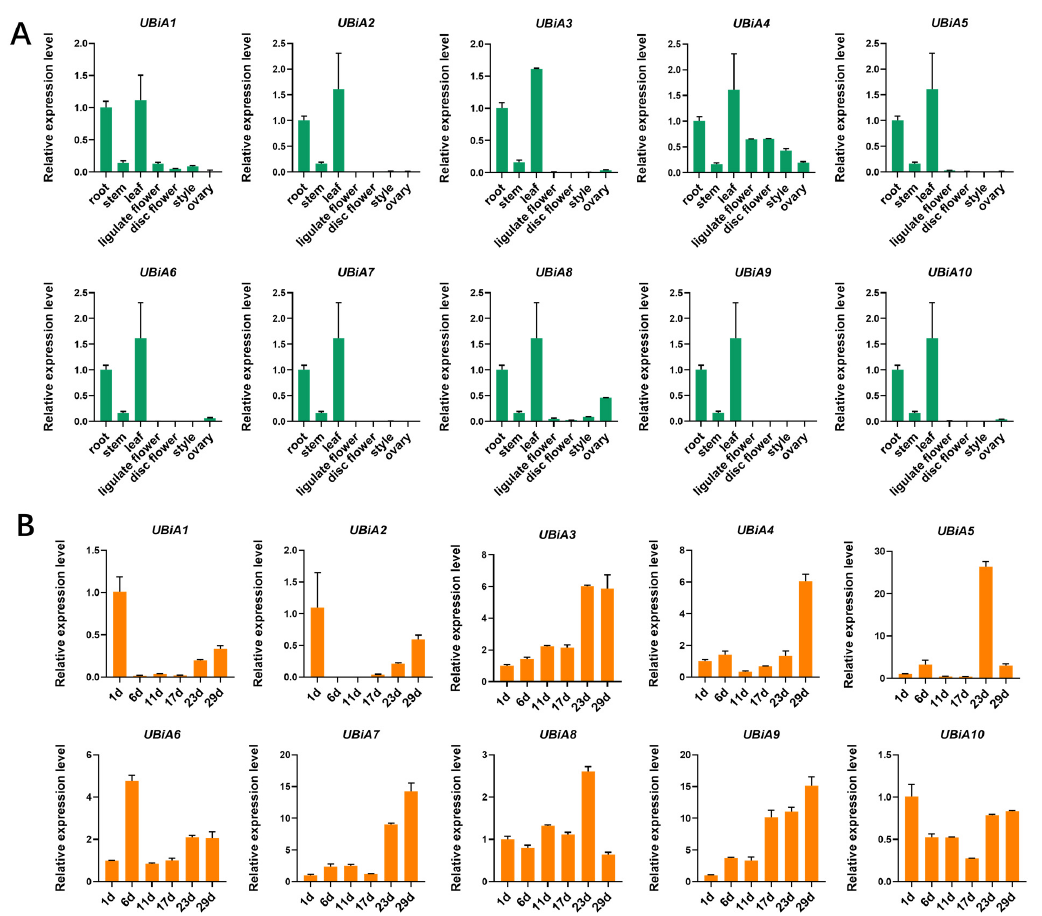
Figure 4. Expression analysis of 10 HaUBiA genes in different tissues and at different stages of seed maturity in H. annuus . ( A ) The relative expression of 10 HaUBiA genes in different tissues using qRT-PCR. ( B ) Relative expression of 10 HaUBiA genes in seeds. Six time points were designed from the first day after flowering to the full maturity of the seeds. HaTubulin was used as an internal